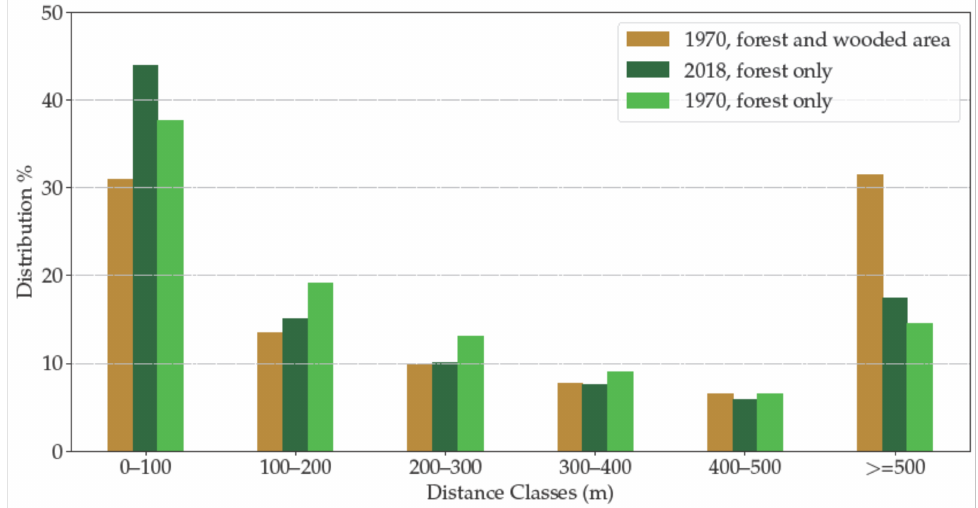
Figure 6. Distribution of distance classes from forest